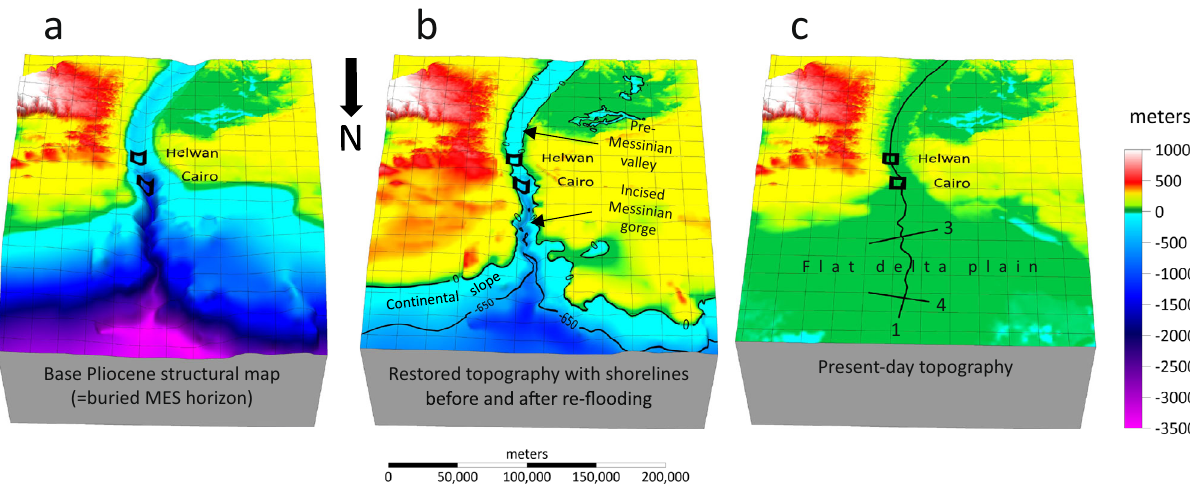
Fig. 3 3D view of the Nile delta and the buried Messinian canyon illustrating landscape evolution being restored. a Base Pliocene structural map ( = MES). b Restored topography for the earliest Pliocene immediately after sea level recovery and prior to any Pliocene deposition (shale parameters for decompaction and Te = 30 km for de fl ection, same as Fig. 2 f). The isobath 650 m represents the fallen MSC shoreline. c Present-day topography. Black lines mark locations of cross sections (Fig. 4). Part of the area annotated as “ fl at delta plain ” in the present topography ( c ) was a few hundred m asl in the earliest Pliocene ( b